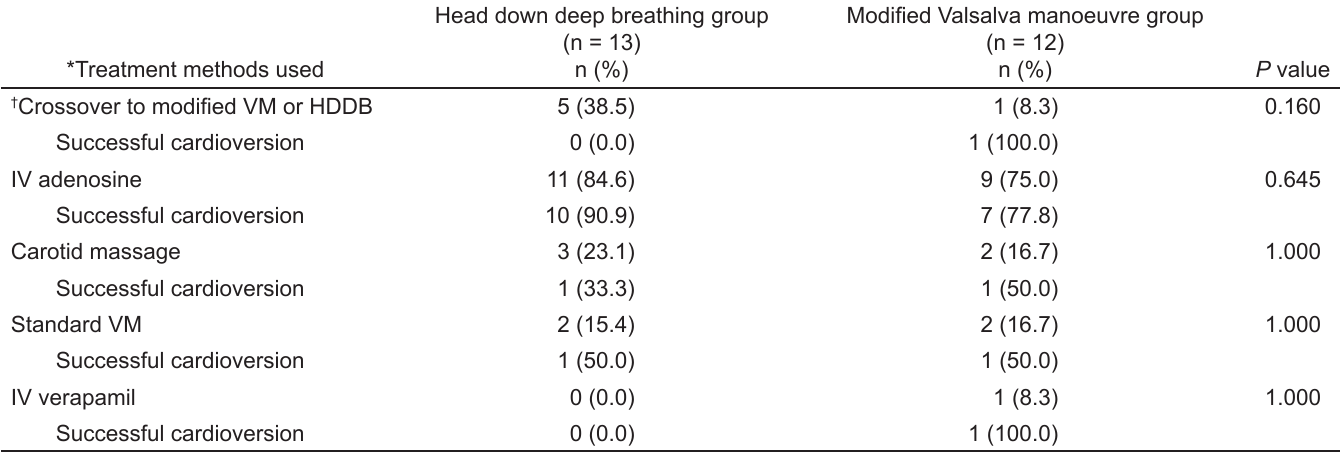
*Total number of treatment methods exceed the number of patients because several patients needed more than one method for cardioversion. Two patients did not have cardioversion to sinus rhythm. † All patients who received crossover treatments had it immediately when the study ended as part of usual care. VM , Valsalva manoeuvre; HDDB , head down deep breathing; IV ,